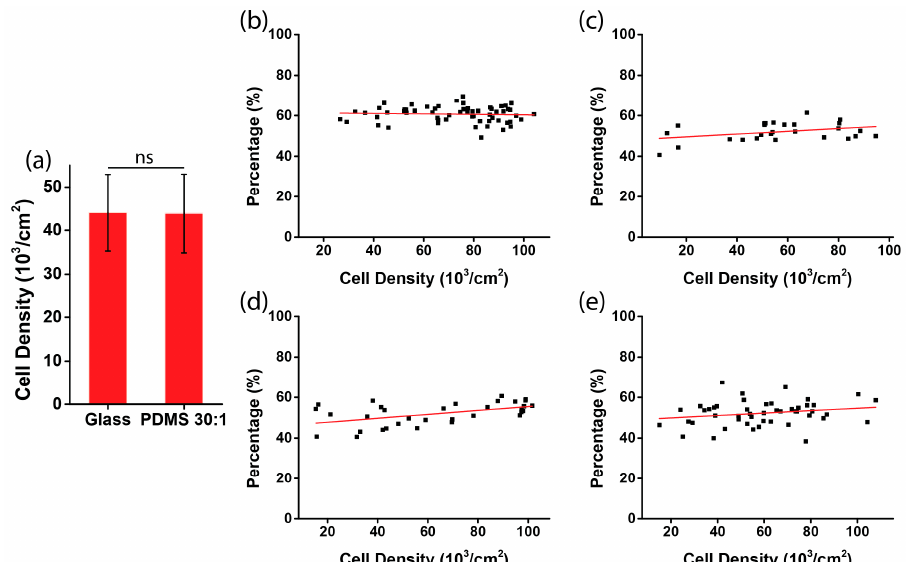
Figure 4. Measurement of cell density in the micropatterned stripes. ( a ) Initial cell density in the stripes on glass and on the PDMS substrate (ratio of elastomer to cross-linker = 30:1); ( b – e ) the percentages of negatively aligned cells with respect to cell density. The stripes were micropatterned on substrates of glass ( b ); PDMS, ratio of elastomer to cross-linker = 3:1 ( c ); PDMS, ratio of elastomer to cross-linker = 10:1 ( d ); and PDMS, ratio of elastomer to cross-linker = 30:1 ( e ).